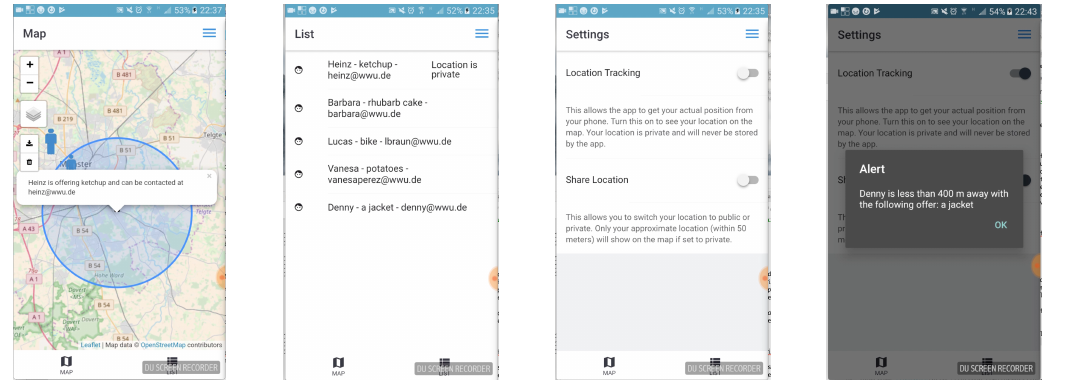
Figure 3. GeoFreebie (left to right): ( a ) approximate location of the users shown in a blue circle; ( b ) marked location info as private; ( c ) setting options to adjust location tracking and location sharing; ( d ) notification pop-up if the location sharing and tracking are